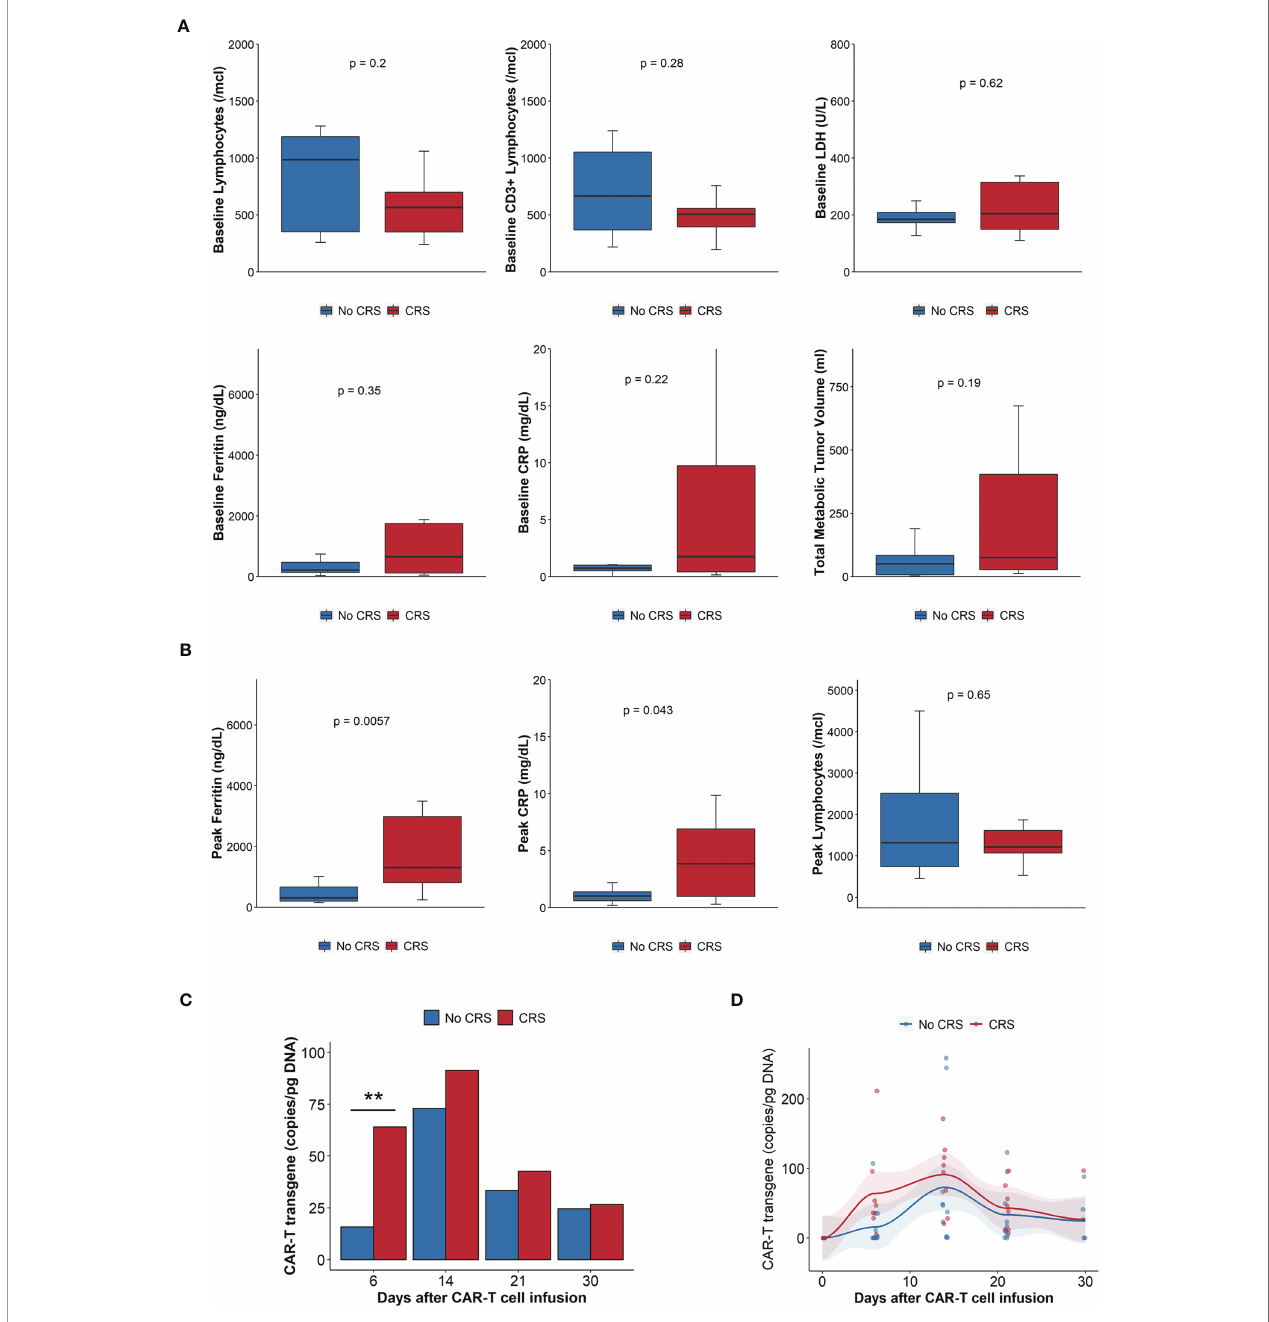
FIGURE 1 | Laboratory parameters, tumor burden and CAR-T cell expansion. (A) Baseline laboratory parameters (n = 20): clockwise: absolute lymphocyte count, CD3+ lymphocytes, LDH, total metabolic tumor volume, CRP, ferritin. Comparisons done with Wilcoxon rank sum test. (B) Peak laboratory parameters: Ferritin, CRP, absolute lymphocyte count. Blue boxes, bars, dots and lines represent results of patients without CRS, red boxes, bars, dots and lines those with CRS. CRP: C reactive protein; CRS: cytokine release syndrome; LDH: Lactate dehydrogenase. Comparisons done with Wilcoxon rank sum test. (C) Mean CAR-T transgene expansion, measured by qPCR, 6, 14, 21 and 30 days after infusion. N = 13. Comparisons done with Wilcoxon rank sum test. **p < 0.01. (D) Scatterplot of CAR-T expansion measured by qPCR, trends generated by locally estimated scatterplot smoothing (loess), AUC of CAR-T transgene (copy/pg DNA x days), n = 13, compared with Wilcoxon rank sum test, p = 0.16. Blue boxes, bars, dots and lines represent results of patients without CRS, red boxes, bars, dots and lines those with CRS. AUC, Area under the curve; CRP, C reactive protein; CRS, cytokine release syndrome; LDH, Lactate dehydrogenase qPCR, quantitative polymerase chain